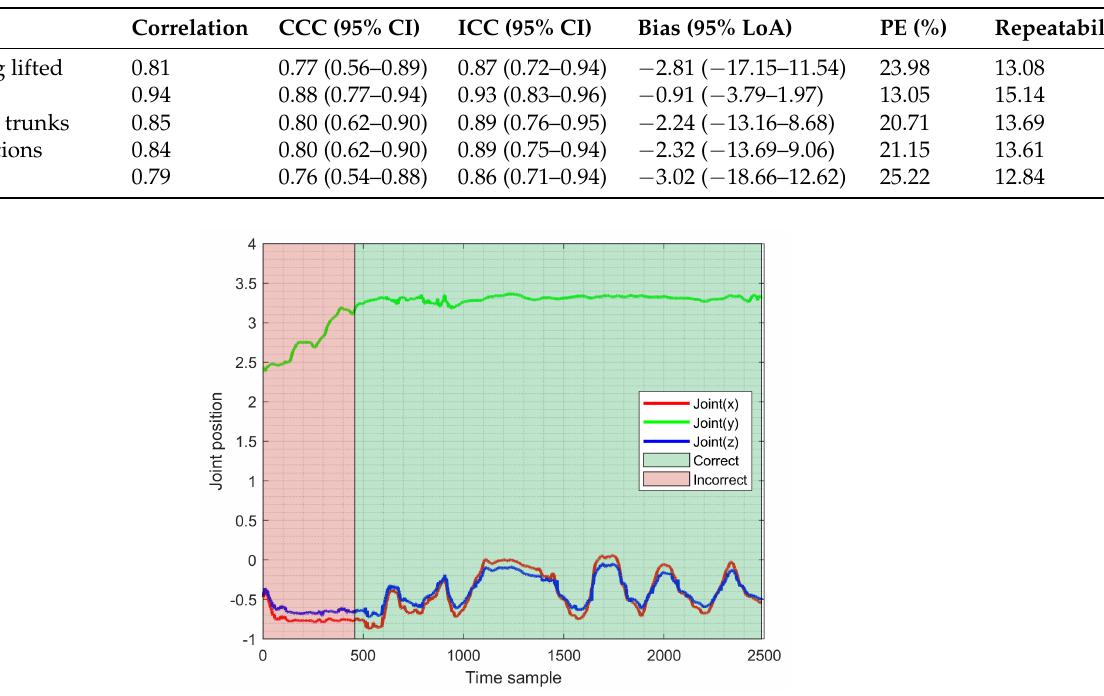
Table 5. The Pearson’s correlation, CCC and ICC (with respective confidence intervals), Bland-Altman bias and LoA’s, percentage error (PE), and repeatability coefficients.